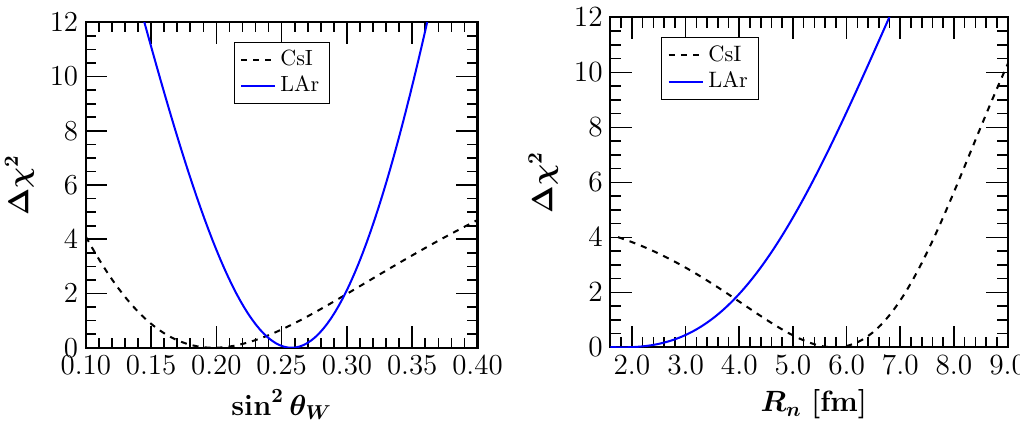
Figure 2 . Sensitivity on the weak mixing angle (left) and on the neutron rms radius (right). A comparison between the results obtained with LAr and CsI detectors is also shown.